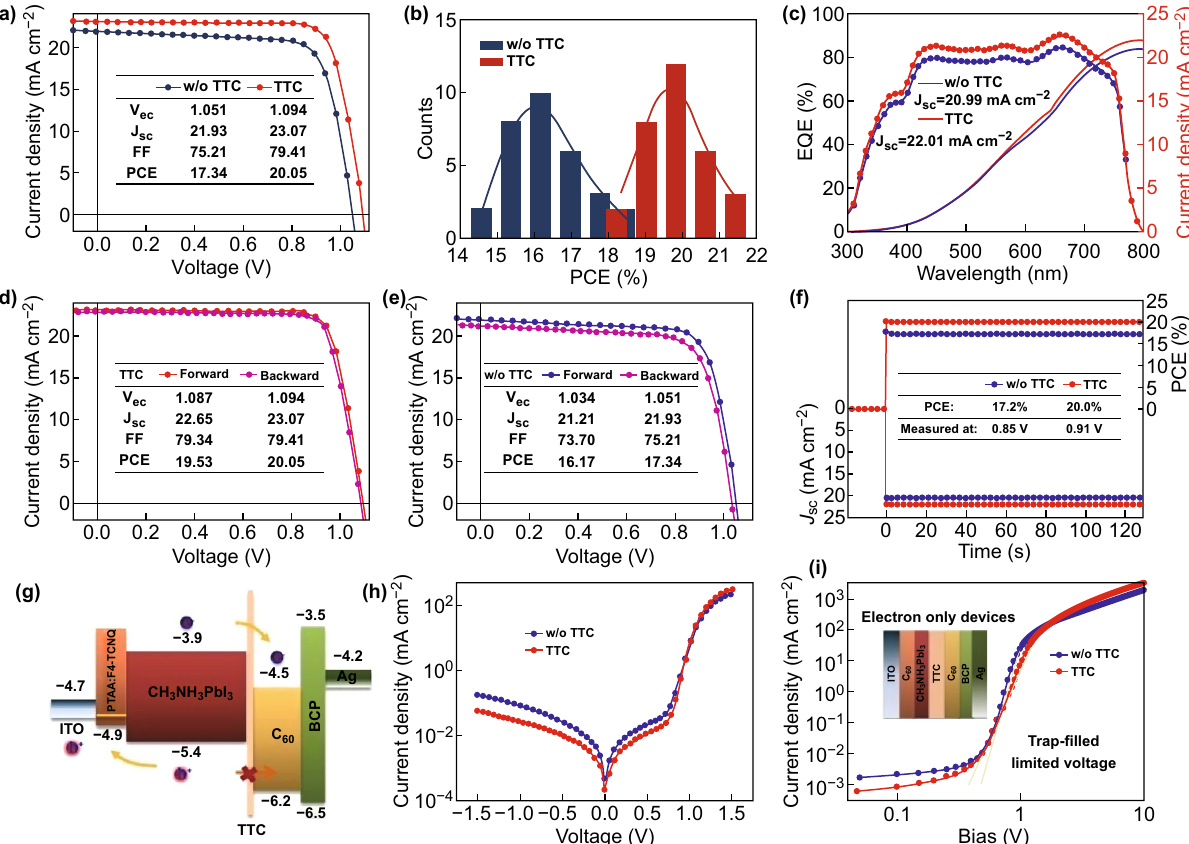
Fig. 3 a J – V characteristics of the devices without and with TTC. b Statistics of PCE distribution for devices without and with TTC (a batch of 32 solar cells). c EQE and integrated current curves of devices without and with TTC. Current–voltage hysteresis curves of the devices d with TTC layers and e without TTC layers. f Steady-state measurement of J sc and PCE for the devices without and with TTC layers. g Energy band level diagram of the corresponding materials used in PVSCs. h J – V characteristics of devices without and with TTC in dark. i J – V characteris- tics of electron-only devices without and with TTC. The structures of electron-only device are